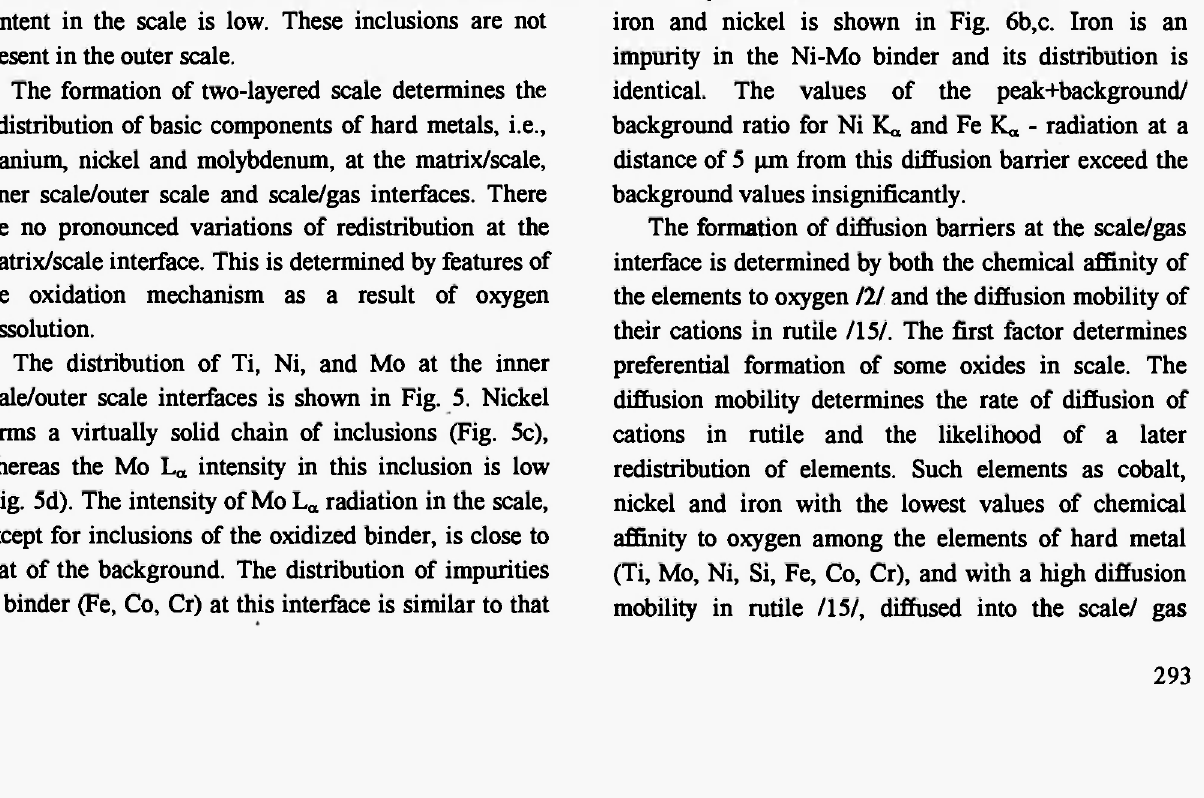
Α Β Fig. 4: Fig. 4: Scheme of mechanism of formation of the inner scale in TiC-Ni-Mo alloy; a - starting alloy; b - inner layer of